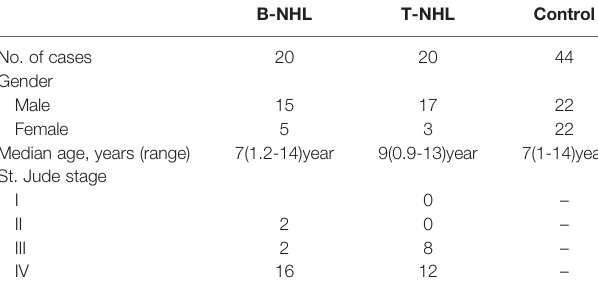
TABLE 1 | Essential features of the research